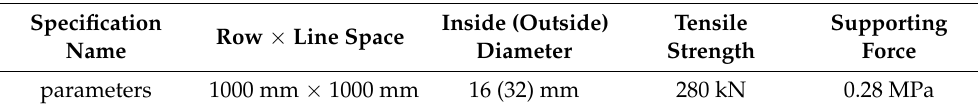
Table 2. Specification of anti-floating